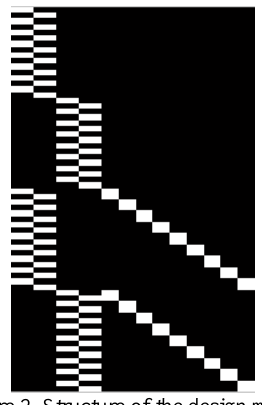
Figure 2. Structure of the design matrix